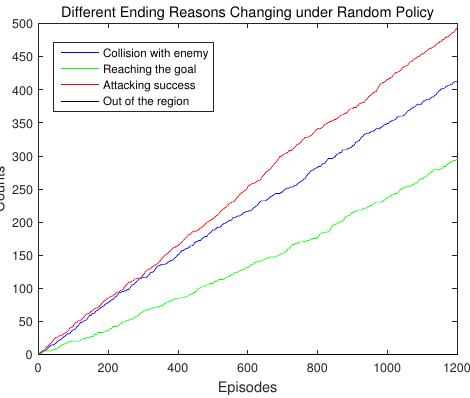
Figure 11. The numbers of different ending reasons when using the random